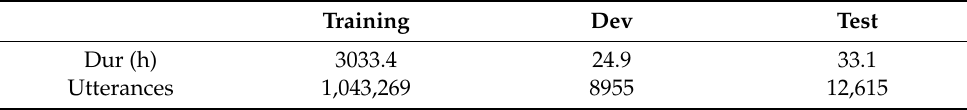
Table 1. Speech data for Arabic dialect